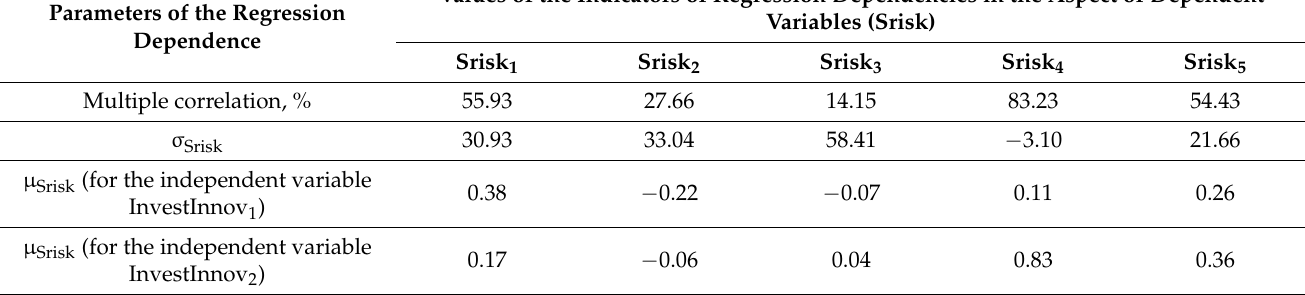
Table 6. Dependence of the social consequences (Srisk) on investments in innovation (InvestInnov). Parameters of the Regression